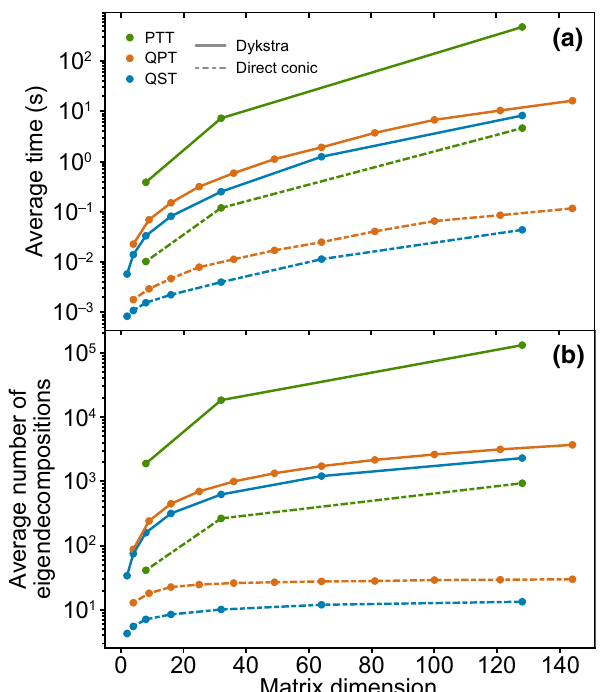
FIG. 4. A comparison between projection methods imposing physical conditions on 500 normally distributed random matri- ces. (a) The average time taken for a single projection for both Dykstra’s alternating-projection algorithm and the direct conic projection. We compare conditions set by QST, QPT, and PTT. (b) The average number of eigendecompositions for each of the above. This dominates the run time of each